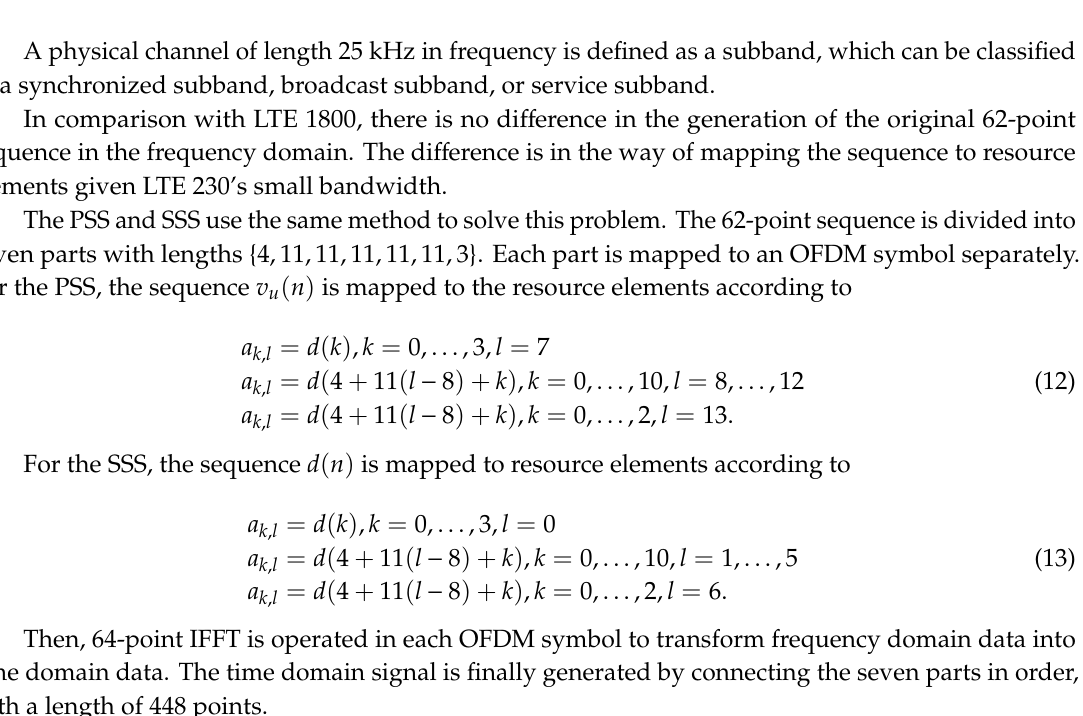
Figure 8. Illustration of the PSS and SSS in an LTE 230 subframe. 4.3. Downlink Synchronization and Cell Search